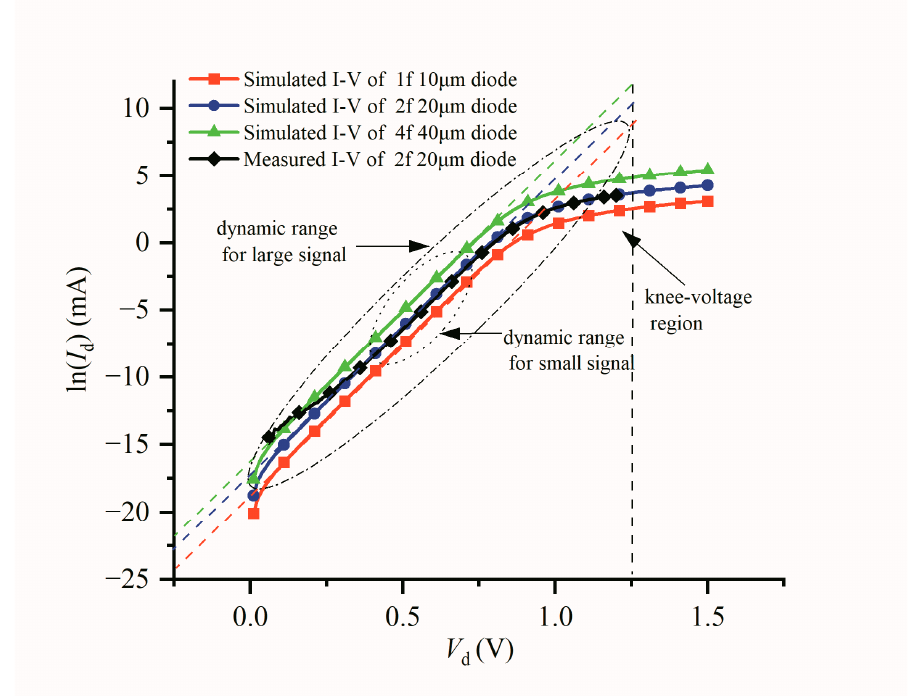
Figure 3. I-V curve for different sizes of GaAs pHEMT Schottky diodes. It can be seen from Table 1 that the four-finger 40 µ m diode has the maximum reverse saturation current I s and the minimum series resistance R s . The linear region slopes of diodes of different sizes are the same, so they have the same ideal factor n Table 1. DC parameter of diodes with di ff erent sizes.